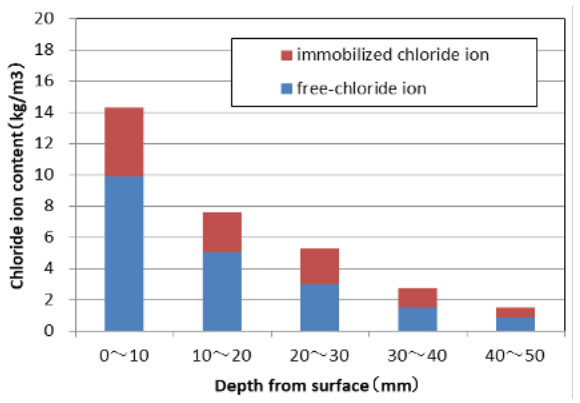
Figure 4. Chloride ion profile for N + CA 2 + Ex.